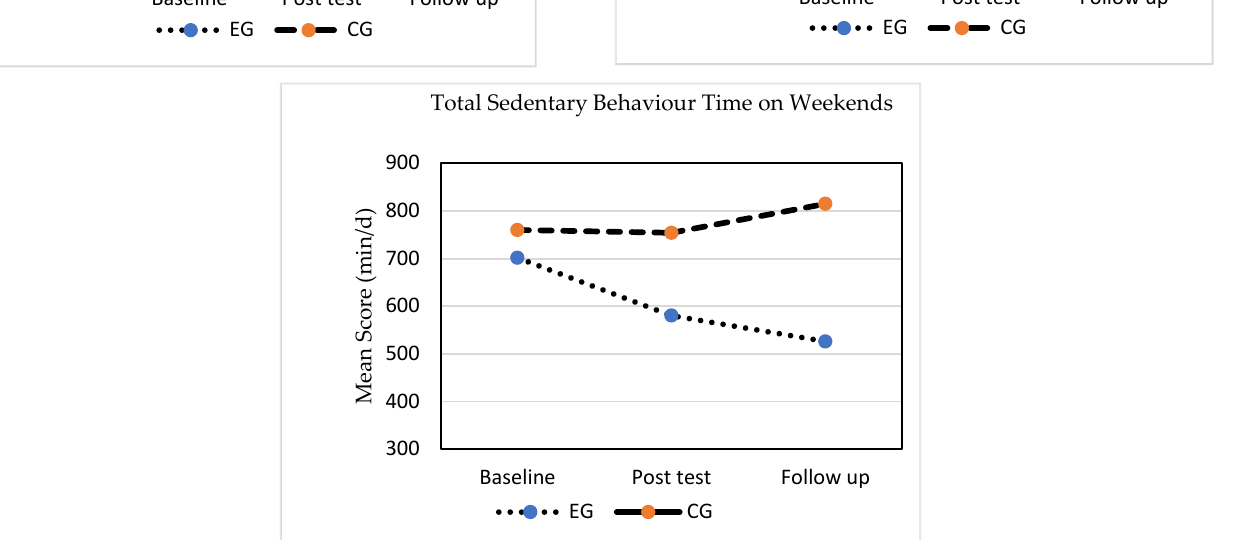
Figure 1. BMI-for-age z-score, waist circumference, physical activity, and screen time and total sedentary behavior on weekdays and weekends for both groups over time .